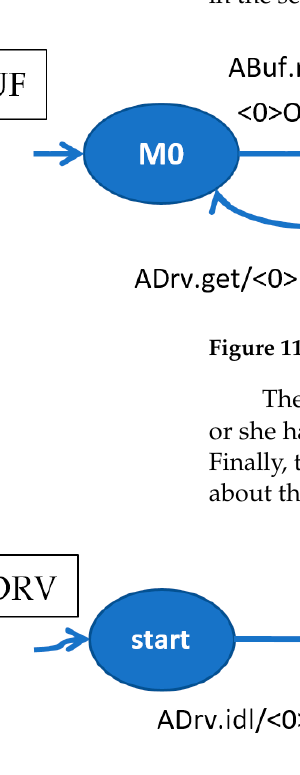
Figure 12. The automaton modeling the driver behavior, DRV.